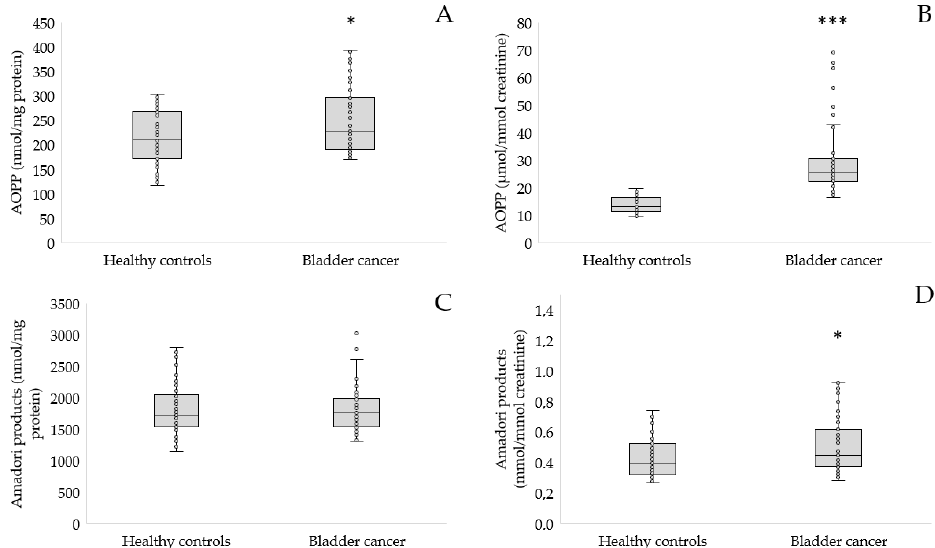
Figure 2. Concentration of AOPP in serum ( A ), urine ( B ) and Amadori products in serum ( C ), urine ( D ) of patients with bladder cancer in comparison to the controls; * p < 0.05, *** p < 0.001.